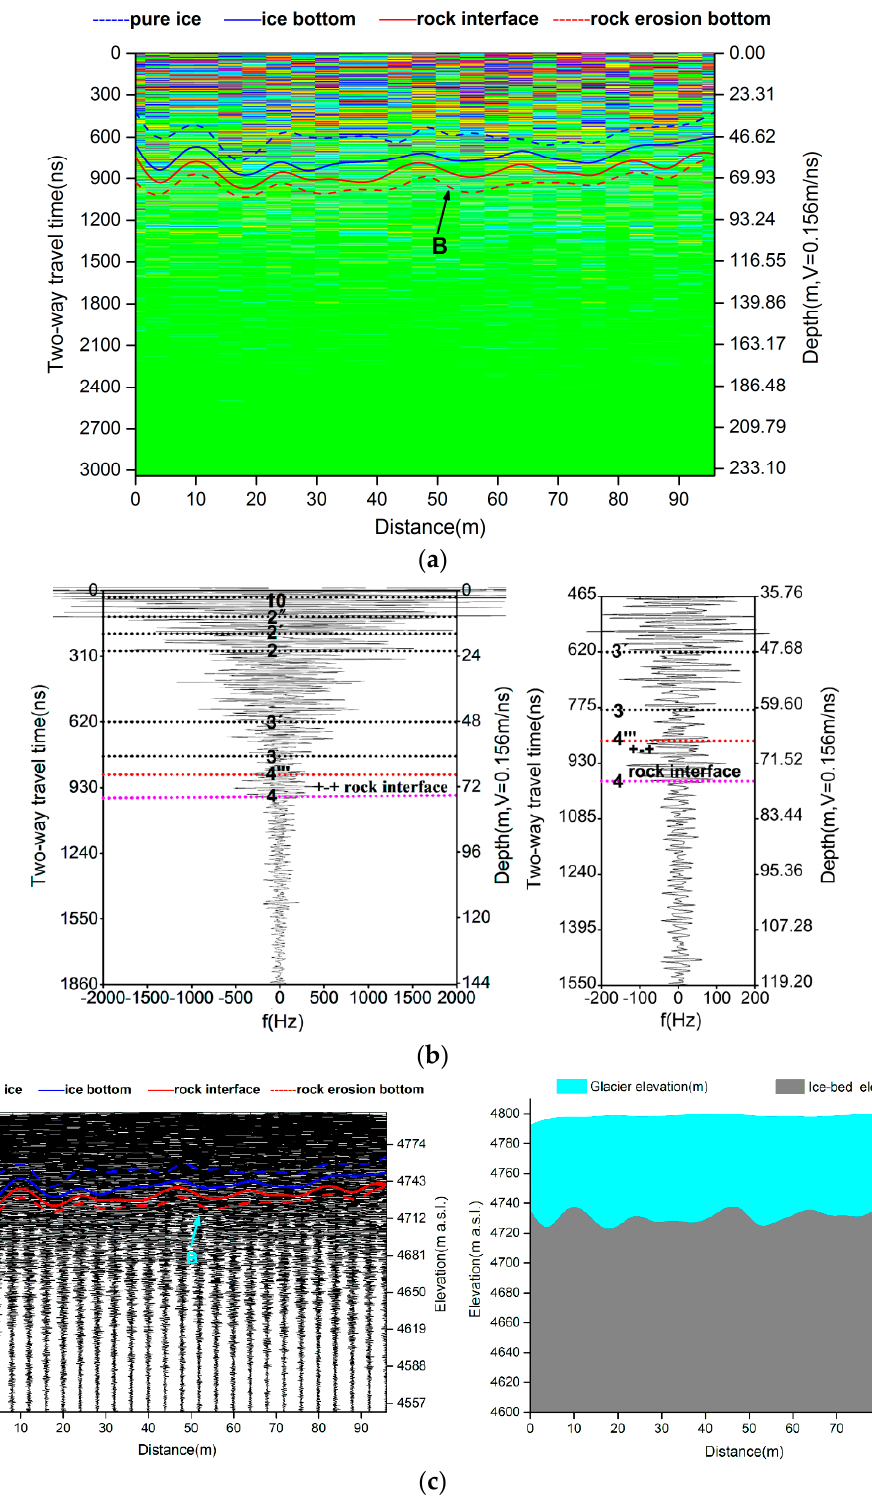
Figure 4. ( a ) The GPR profile and bedrock interface interpretation along longitudinal profile T2 of BRG1 in Mt. Yulong. ( b ) The five-layer structure interpretation results of the reflected wave trace at the measuring point B of profile T2. ( c ) The GPR profile image after elevation correction, as well as a sketch diagram of the ice surface and the bedrock along longitudinal profile T2.